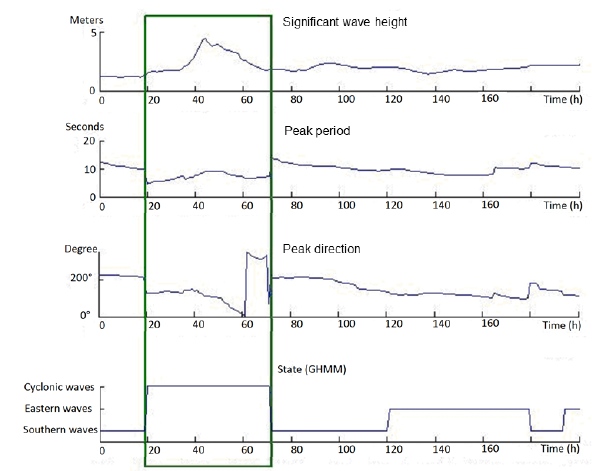
Fig. 3. Example of the automatic identification of cyclone Dina at “Point East” using the GHMM algorithm: The storm’s effects are recognized due to the high temporal variability of the waves’ sig- nificant heights and